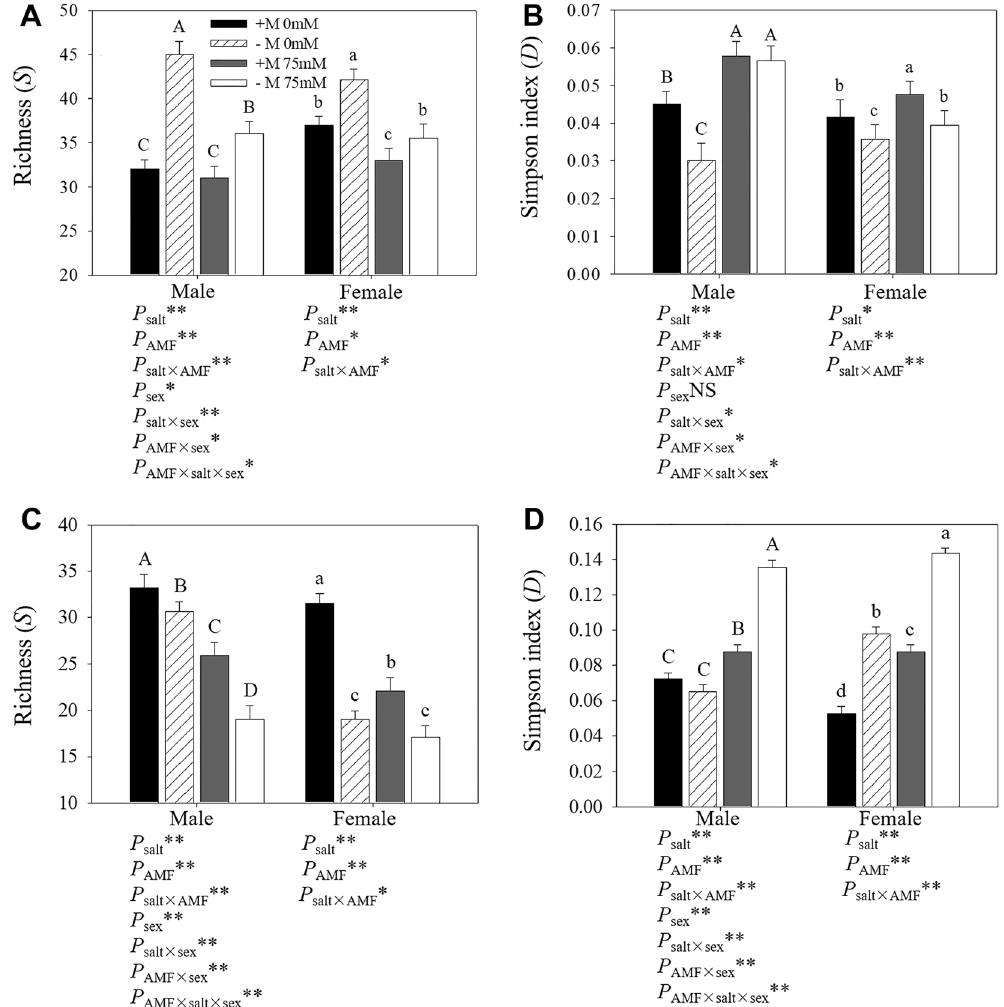
Figure 3. Influence of exogenous AM inoculation and salt stress on bacterial ( A , B ) and fungal ( C , D ) community in the rhizosphere of P . cathayana . +M: exogenous AM inoculation; −M: non-exogenous AM inoculation; 0 mM: without salt stress; 75 mM: under salt stress; **: significant effect at P ≤ 0.01; *: significant effect at 0.01 ≤ P ≤ 0.05; NS: no significant effect P > 0.05. Different letters (capital letters for males and lowercases for females) indicate significant difference ( P ≤ 0.05), the data are means ± SD (n =